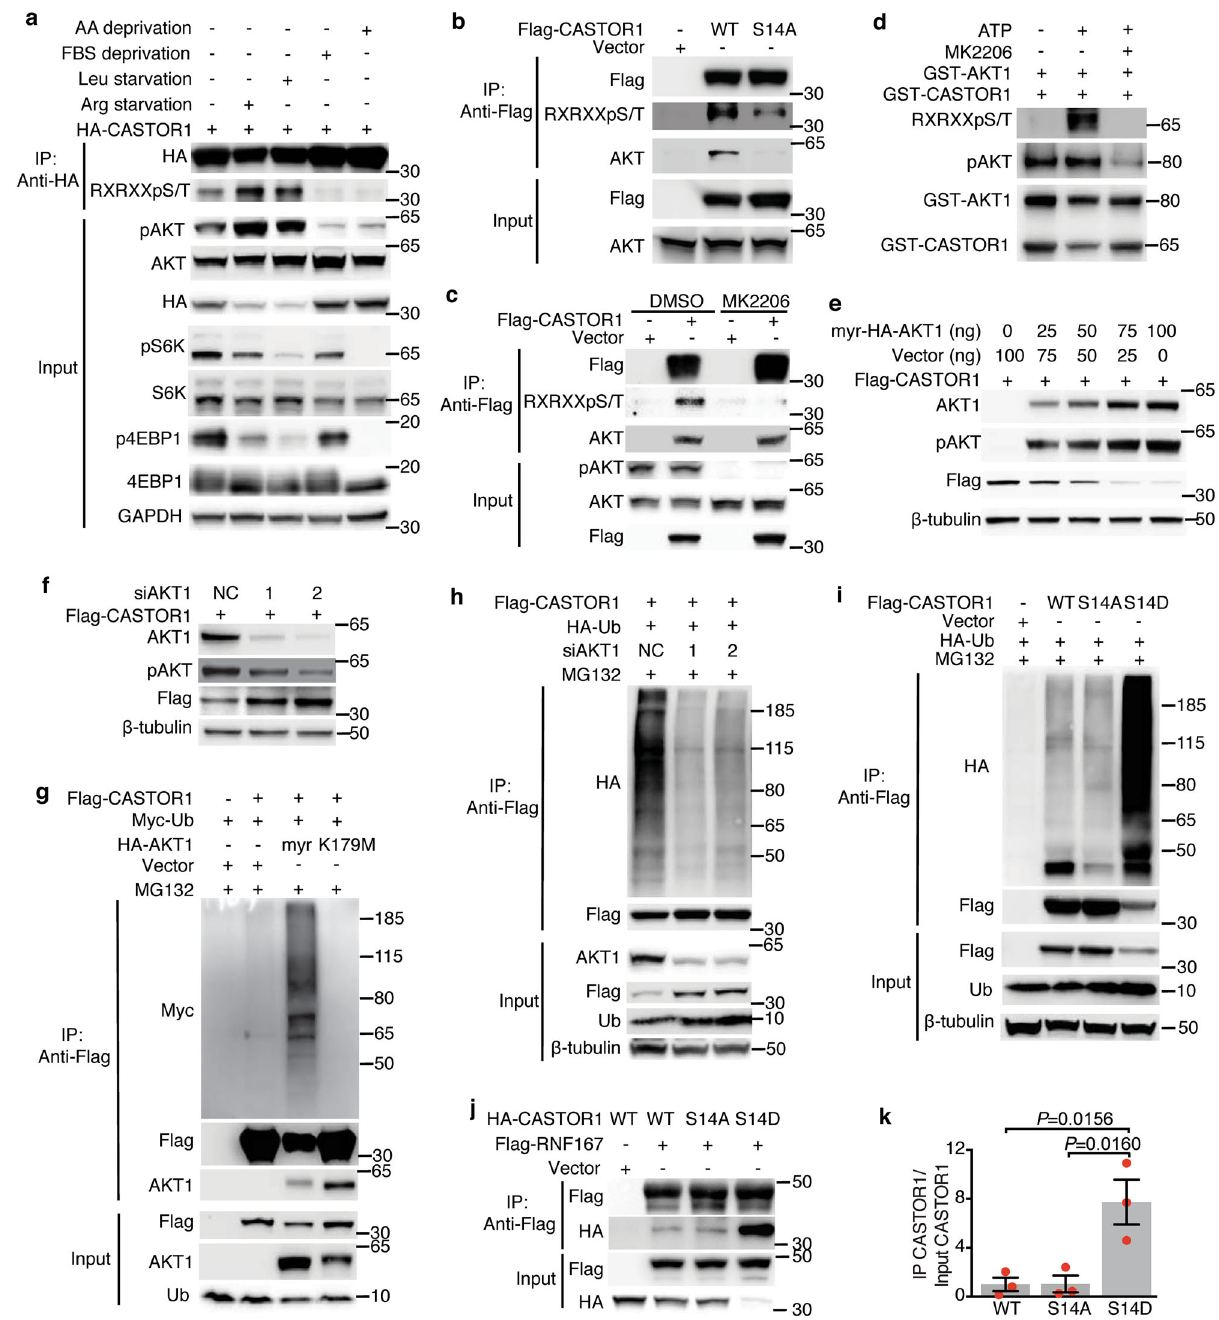
Fig. 2 AKT1 phosphorylation of CASTOR1 promotes RNF167-mediated ubiquitination and degradation of CASTOR1. a Deprivation of arginine or leucine activated AKT and increased CASTOR1 phosphorylation at S14, whereas deprivation of FBS or total amino acids inactivated AKT and reduced CASTOR1 phosphorylation at S14. b CASTOR1 S14 phosphorylation was markedly reduced following alanine substitution (S14A). c AKT inhibition abolished CASTOR1 phosphorylation at S14 in vivo. d Recombinant AKT1 protein directly phosphorylated CASTOR1 protein in vitro. e , f AKT overexpression increased ( e ) while AKT1 knockdown decreased ( f ) CASTOR1 degradation. g , h AKT1 overexpression increased ( g ) and AKT1 knockdown decreased ( h ) CASTOR1 ubiquitination. i CASTOR1 S14D had increased ubiquitination level compared to WT and S14A. j , k Phosphorylation of CASTOR1 at S14 signi fi cantly increased its af fi nity to RNF167 ( j ), and quanti fi cations of results from three independent experiments are presented ( k ). For k , data are presented as mean values± SEM and P value was calculated by one-way ANOVA followed by Tukey post hoc test ( n = 3 independent experiments). Blots in a – c , e – j are representatives of n = 3 independent experiments, and blots in d are representatives of n = 2 independent experiments. Source data are provided in Source data fi